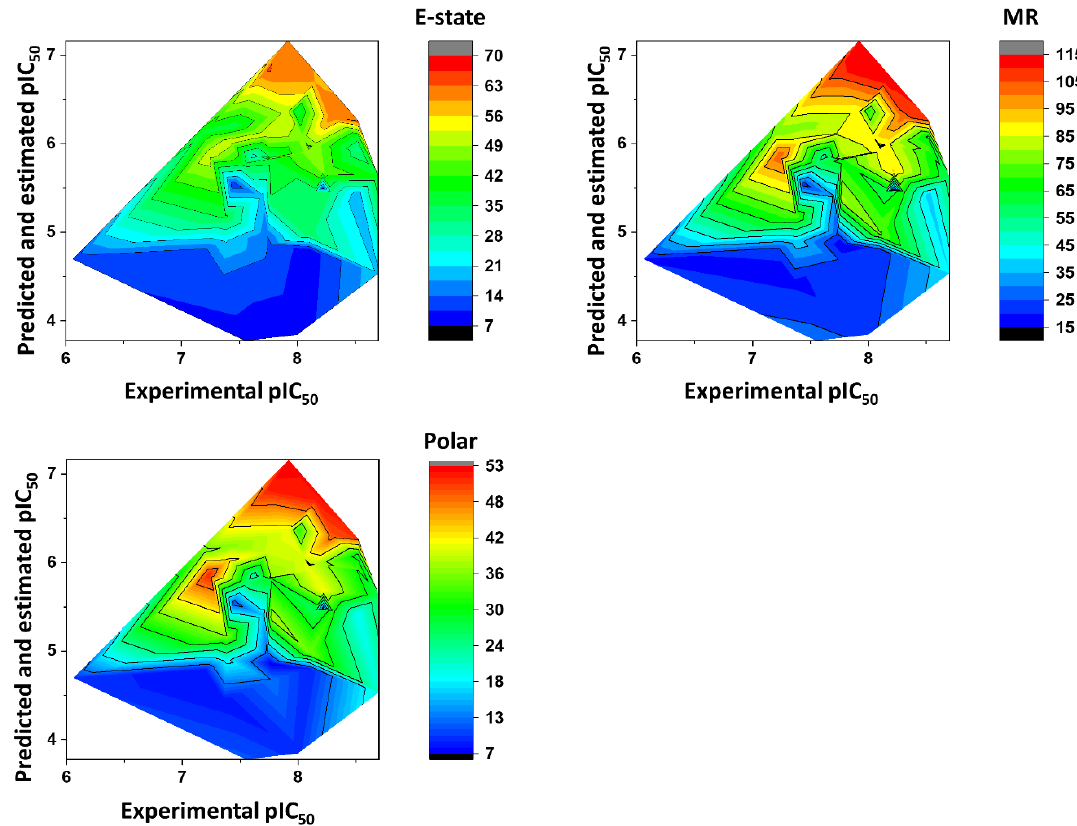
Figure 10. Heat maps showing the correlation between physicochemical properties and biological activity for molecular fragments extracted from the dataset. Note: E-state = electrotopological state; MR = molar refractivity; Polar = molecular polarizability.